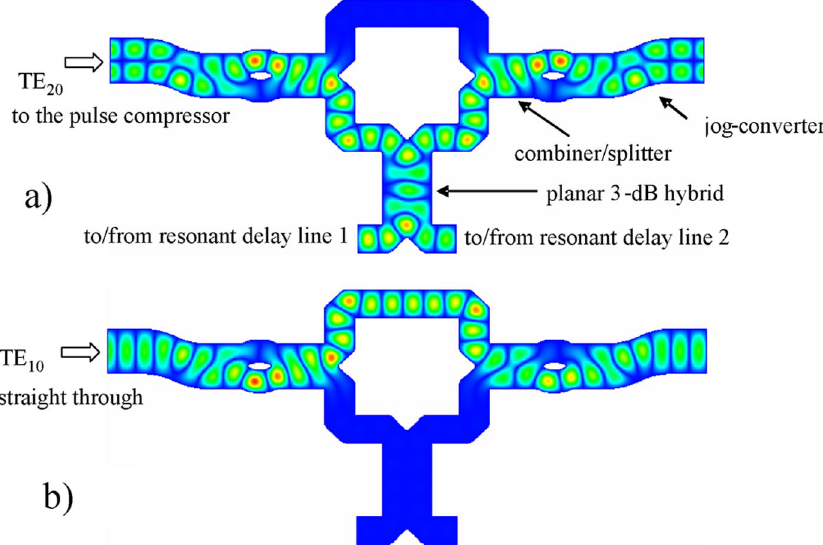
FIG. 10. (Color) The geometry and simulated electric field snapshots of the planar superhybrid with delay line ports shorted for input and (b) TE (a) TE 20 10